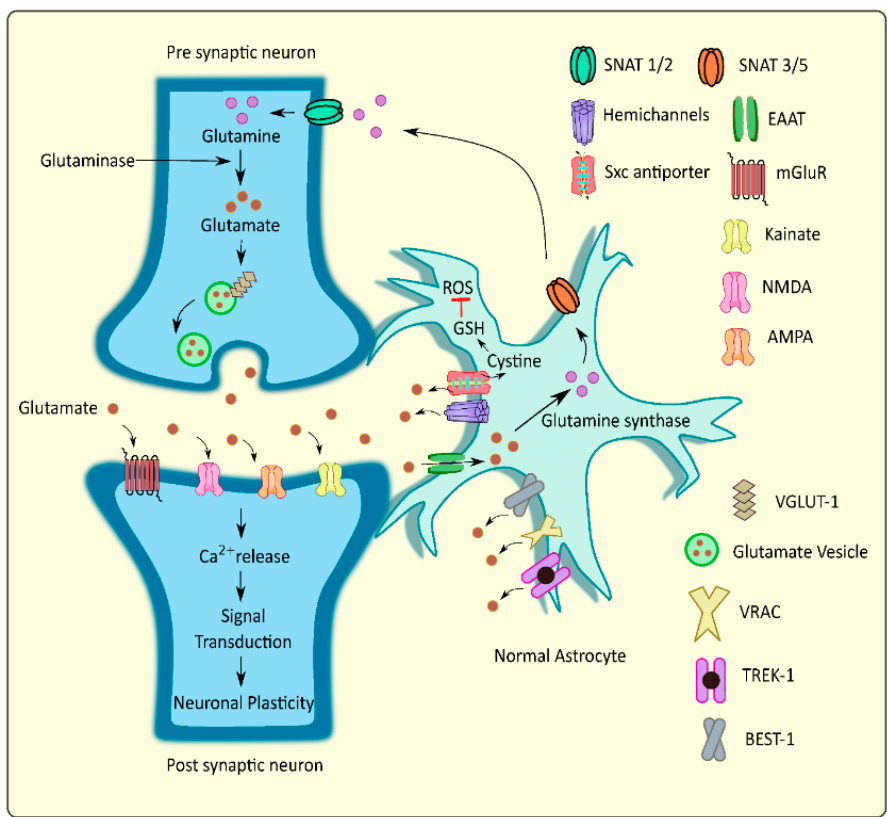
Figure 2. Schematic representation of glutamate homeostasis at the tripartite glutaminergic synapse. Reprinted from an open-access source [12]. Abbreviations: SNAT—sodium-coupled neutral amino acid transporter; Sxc antiporter—cystine/glutamate antiporter system xc; EAAT—excitatory amino acid transporter; NMDA—N-methyl-d-aspartate; AMPA—alpha-amino-3-hydroxy-5-methyl-4-isoxazolepropionic acid; VGLUT—vesicular glutamate transporter; VRAC—volume regulated anion channels; TREK—TWIK related potassium channel; BEST—bestrophin; ROS—reactive oxygen species; GSH—glutathione.